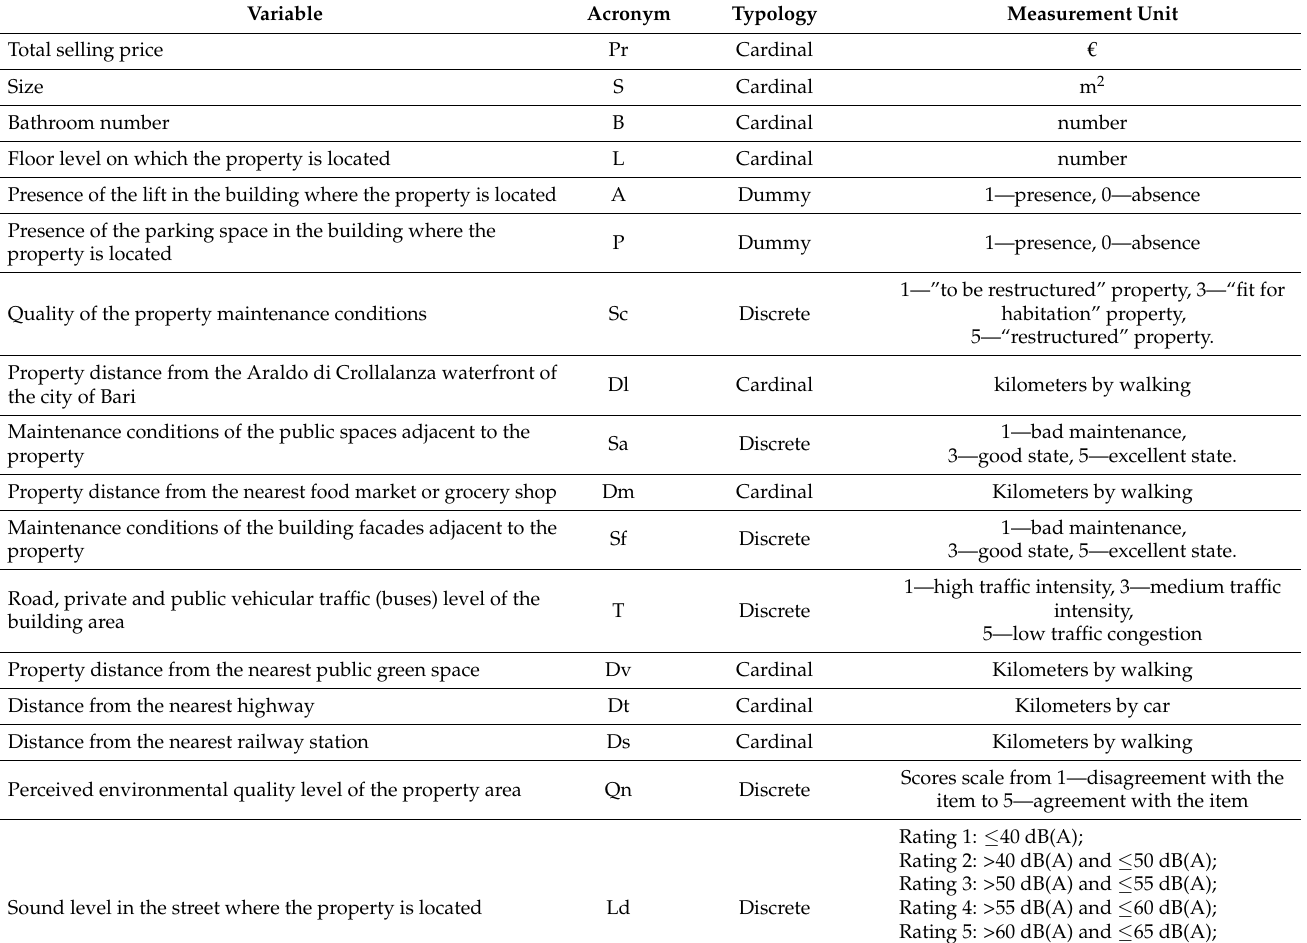
Table 1. Summary of the variables selected in the